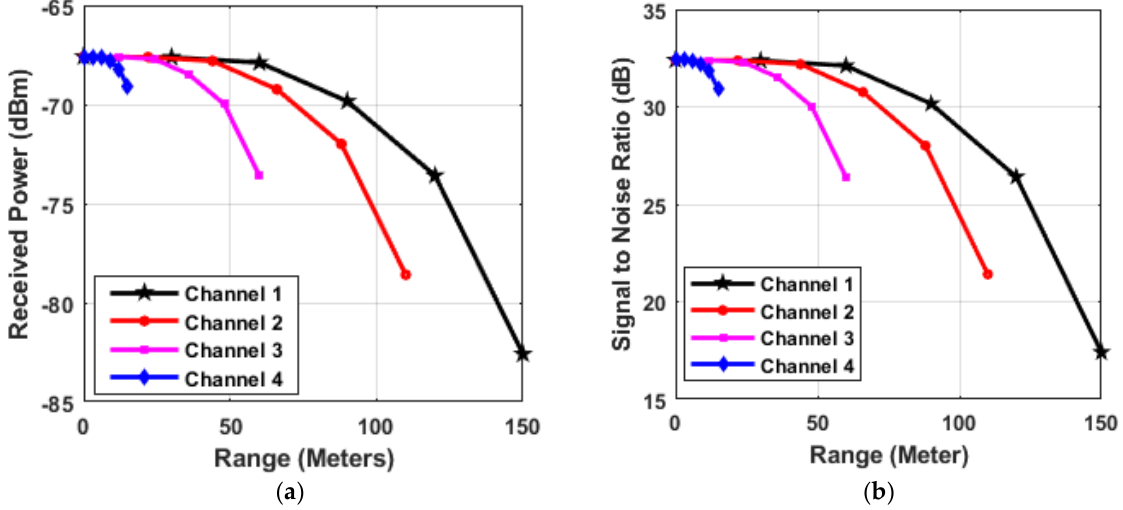
Figure 6. ( a ) Received power and ( b ) signal-to-noise ratio (SNR) with respect to range at 1 GHz bandwidth.